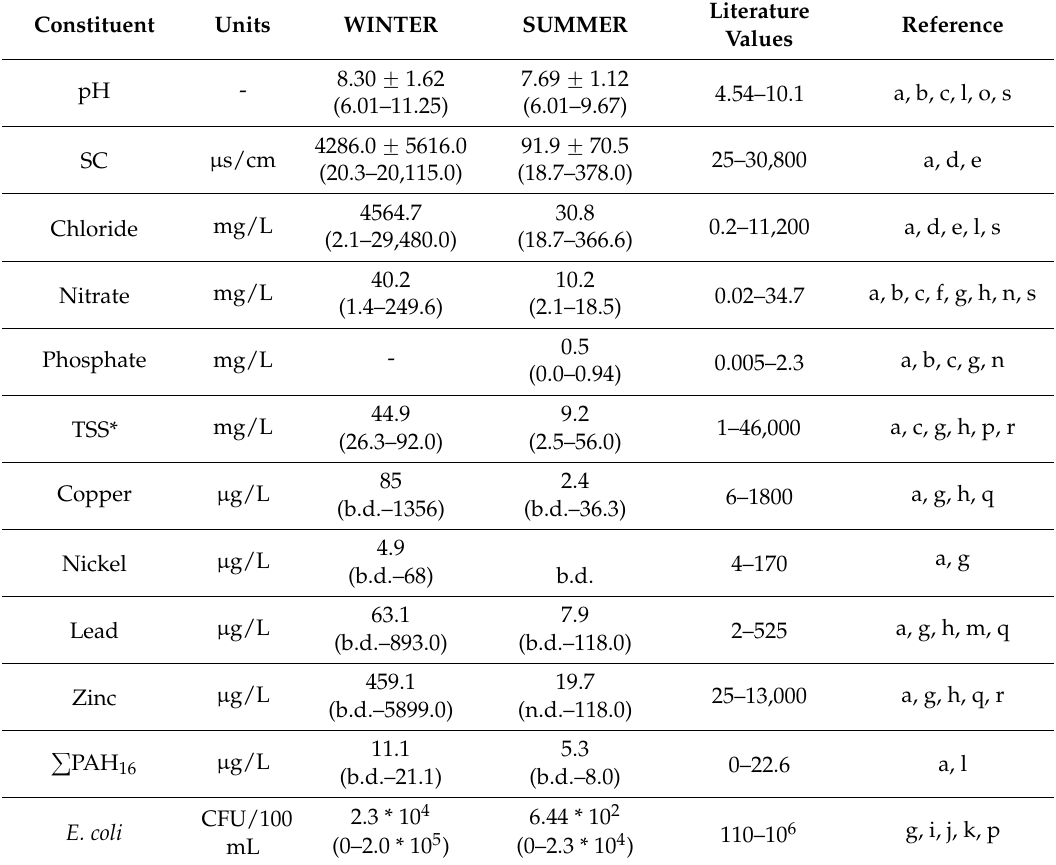
Table 3. Average winter and summer concentrations for stormwater influent with concentration ranges in parentheses along with reported literature values for the following parameters: pH, Specific Conductance (SC), Chloride, Nitrate, Phosphate, total suspended solids (TSS), Copper, Nickel, Lead, Zinc, Polycyclic Aromatic Hydrocarbons, and E. coli